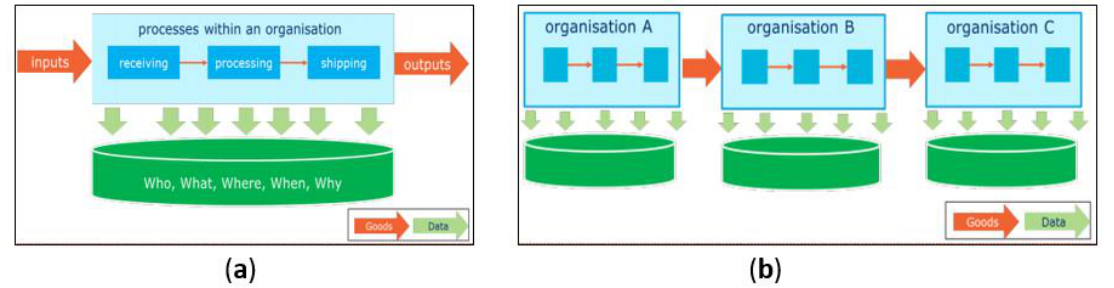
Figure 1. Global Standard for traceability at ( a ) the enterprise-level, and ( b ) at the supply chain level [12].